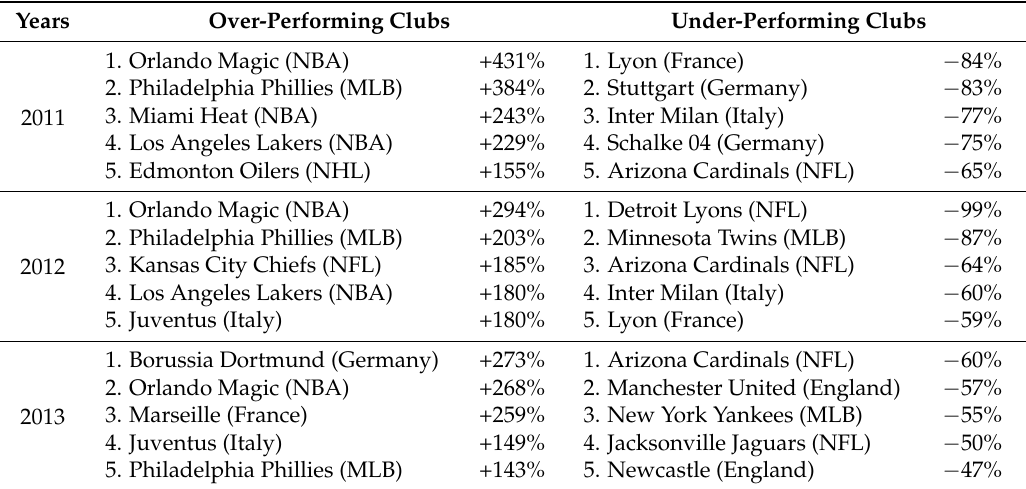
Table 6. Over- and under-performing clubs on Twitter in relative